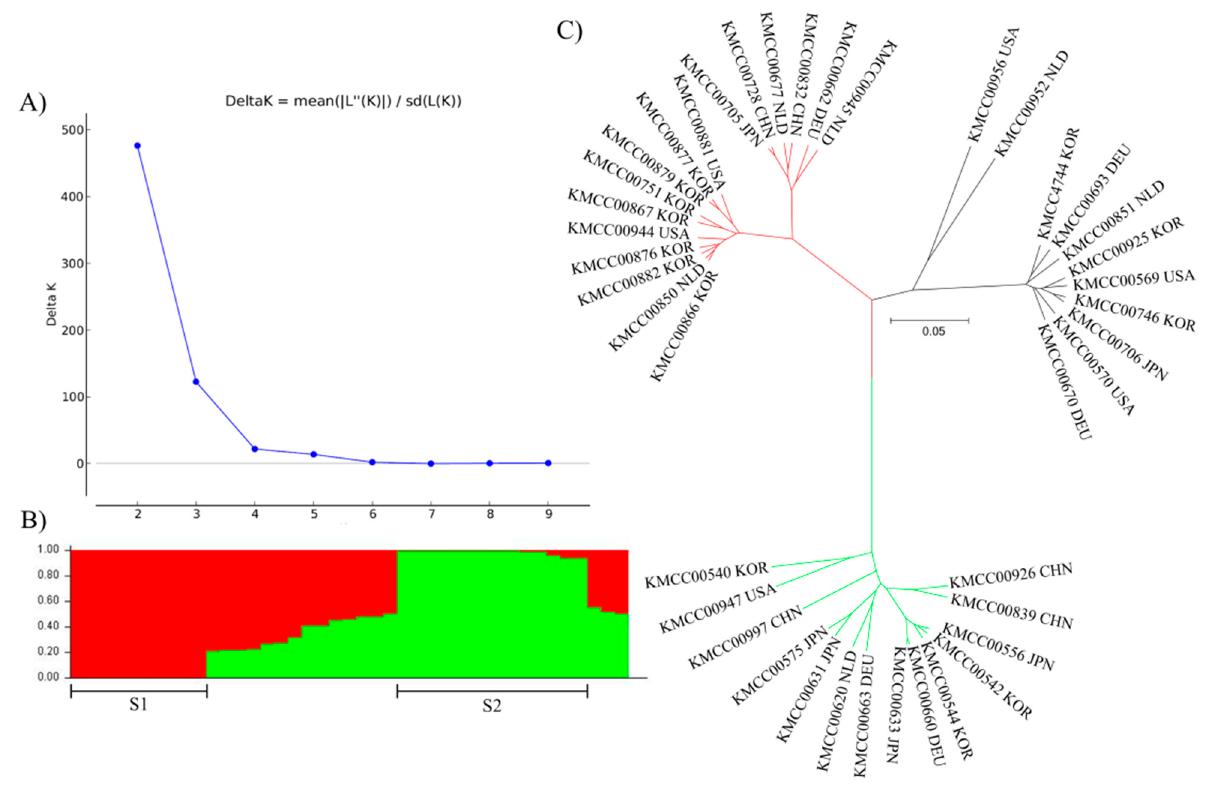
Figure 4. Group structure analysis of Agaricus bisporus accessions. The most appropriate number of groups was determined by repeating five iterations using Structure Burn-in and Markov Chain Monte Carlo (MCMC) with 100,000 iterations. ( A ) Delta K values were calculated using Structure Harvester. ( B ) Probability of each accession belonging to a group. ( C ) Unrooted tree confirmation of population structure.